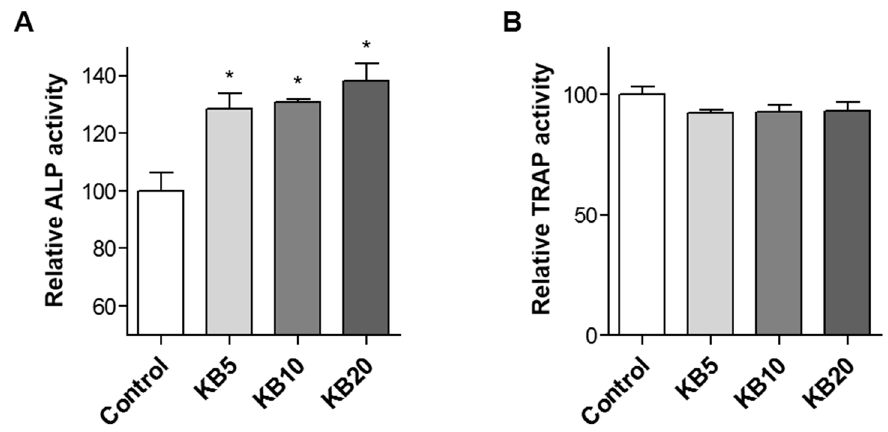
Figure 5. The effects of kukoamine B (KB) on osteoblast and osteoclast differentiation in the co-culture of preosteoblasts and primary-cultured monocytes. Co-cultured MC3T3-E1 and primary-cultured monocyte cells were treated with osteoblast differentiation reagents ascorbic acid and β - glycerophosphate, and then co-treated with KB (5, 10, and 20 μ M) for three days. Alkaline phosphatase (ALP) activity ( A ) and tartrate-resistant acid phosphatase (TRAP) activity ( B ) were assessed in the co-culture cells. Control: KB non-treated cells. *: p < 0.05 vs. Induction (Tukey’s HSD post hoc test, ANOVA).